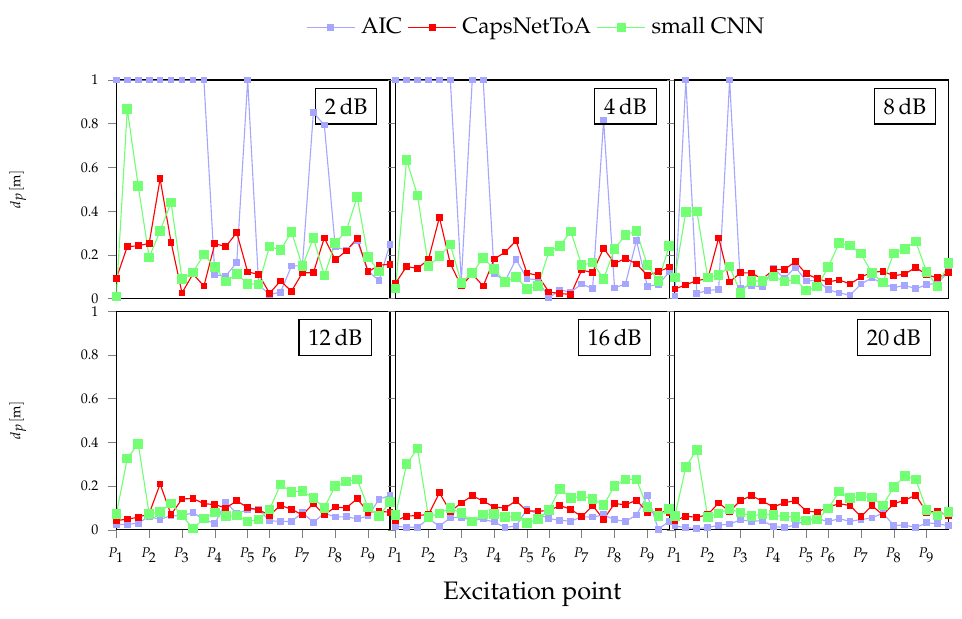
Figure 11. Absolute errors for acoustic signal localization on a laboratory metallic plate under various noise